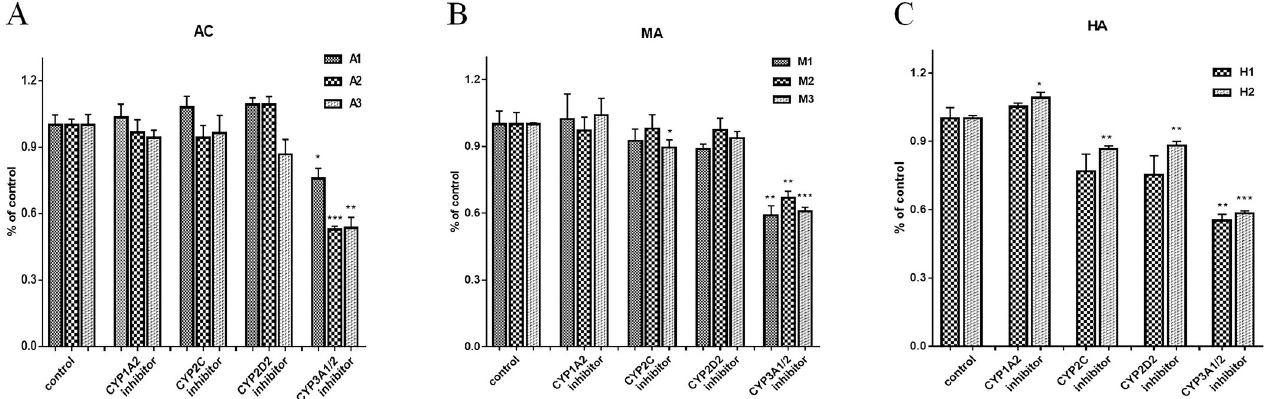
Fig 3. Effects of CYP inhibitors on the formation of AC, MA and HA metabolites. (A) AC; (B) MA; (C) HA. Compared with the control, � P < 0.05; �� P < 0.01; ��� P < 0.001.